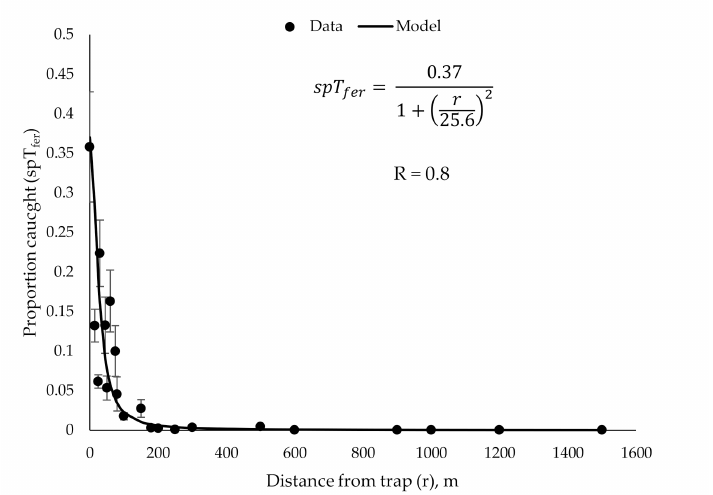
Figure 6. Proportion of released gypsy moth caught times annulus ( spT fer from traps (r) (Miller plot transformation, [28]).